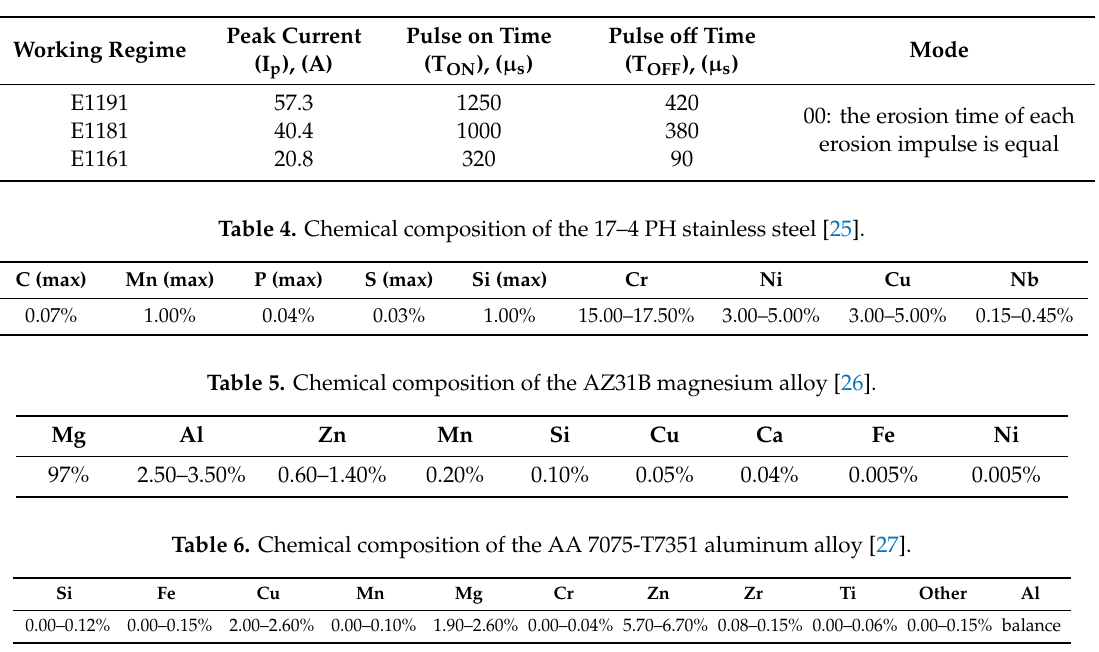
Table 3. Specific parameters of the working regimes [24].